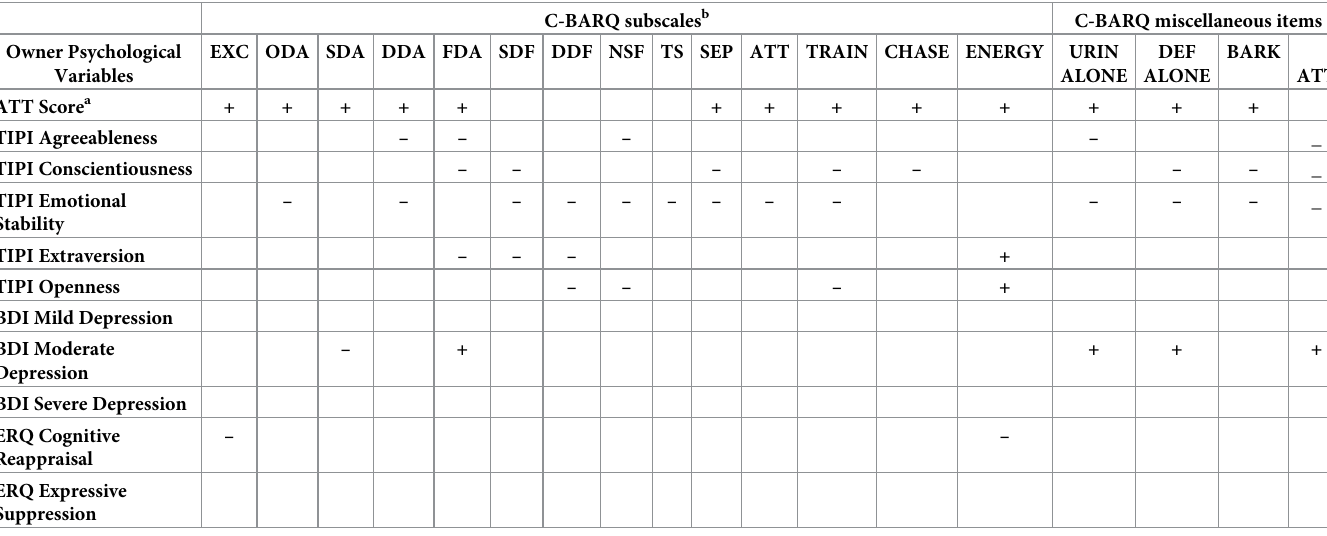
Table 1. All statistically significant associations between owner psychological variables, attitudes to training, and dog mini C-BARQ